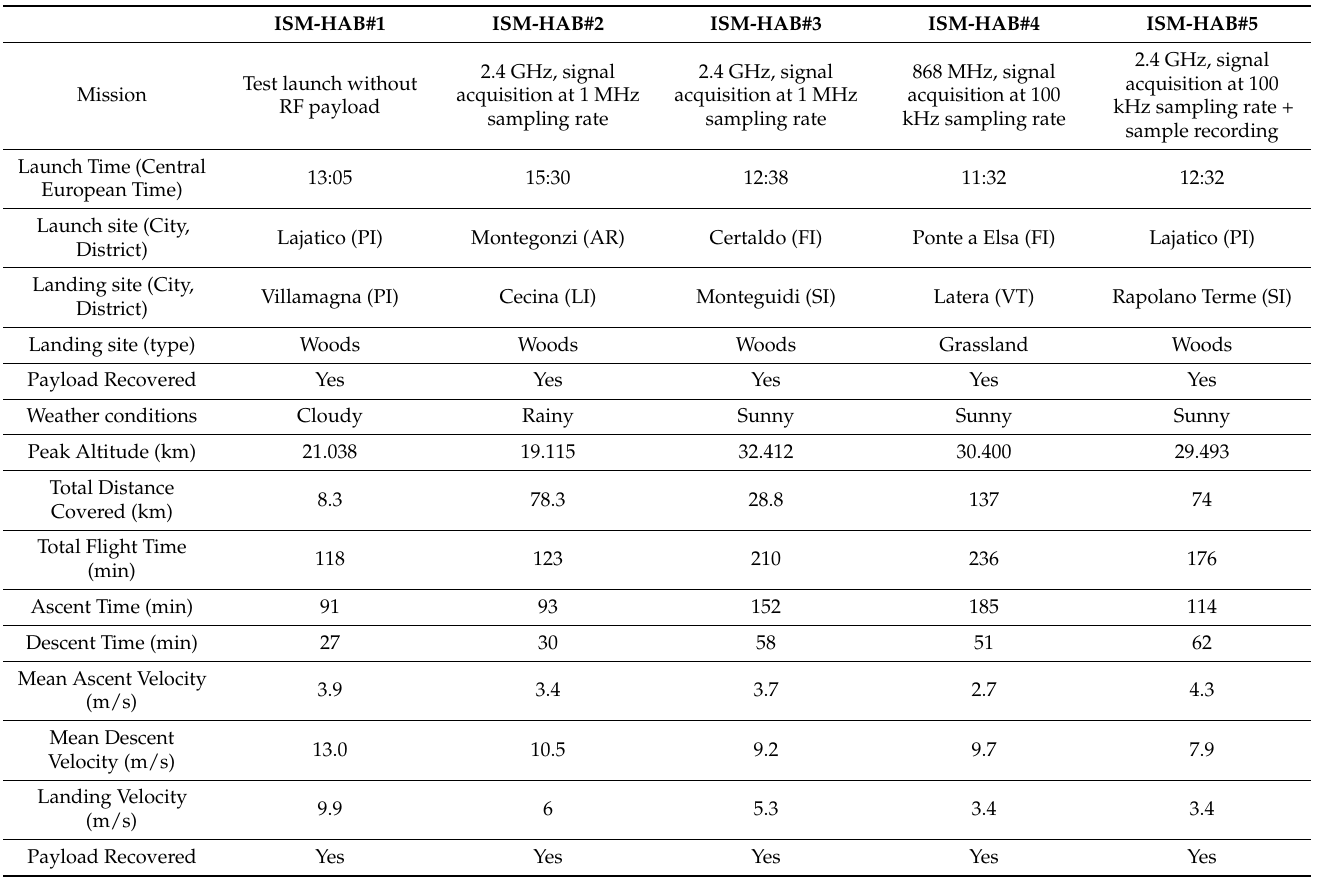
Table 2. Mission